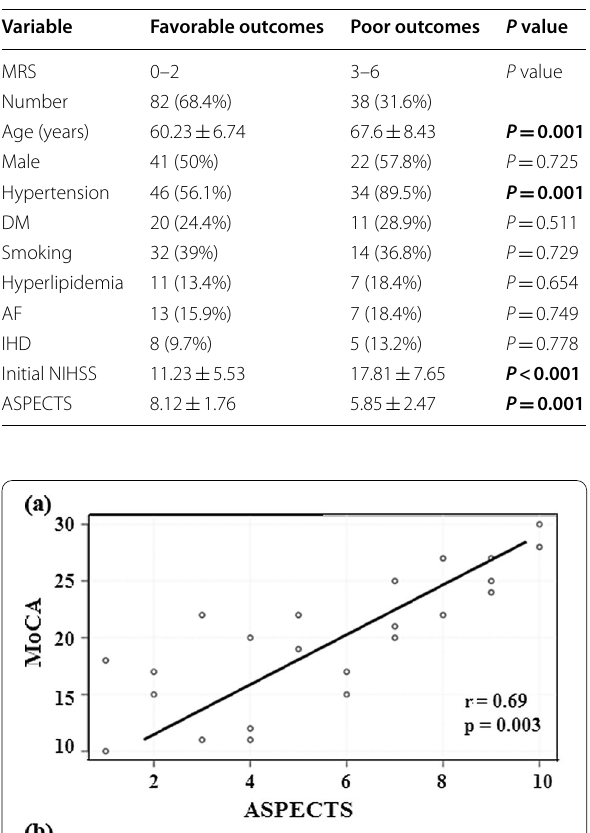
Table 4 Correlation between stroke outcome according to mRS after 3 months and risk factors, initial NIHSS, and ASPECTS